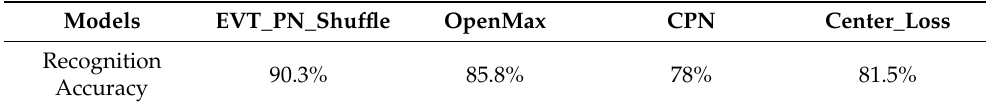
Table 1. Comparison of recognition accuracy of different models.